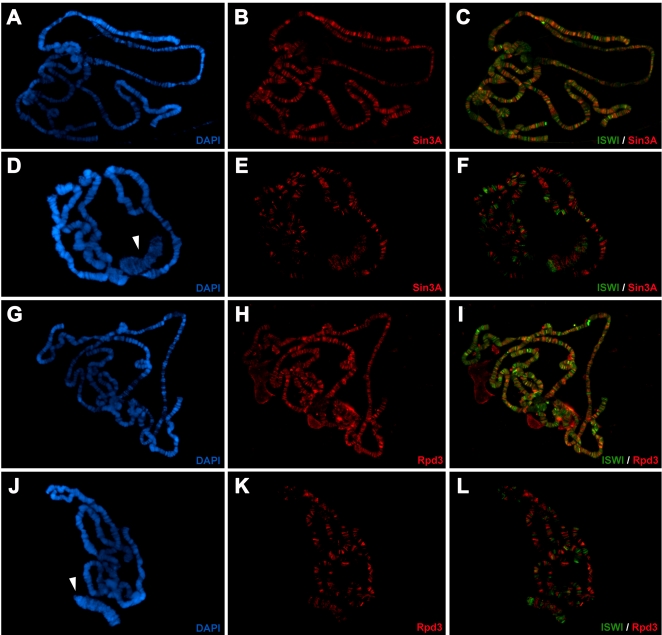
Loss of ISWI reduces the binding of Sin3A and Rpd3 to chromatin.(A and G) DAPI and immunostaining of (B) Sin3A or (H) Rpd3 on wild-type salivary gland male polytene chromosomes. (D and J) DAPI staining and distribution of (E) Sin3A or (K) Rpd3 on ISWI mutant salivary gland male polytene chromosomes. Merge of a double immunostainig for ISWI and Sin3A (C and F) or ISWI and Rpd3 (I and L) on wild-type and ISWI mutant salivary gland male polytene chromosomes, respectively. ISWI mutant chromosomes show a significant reduction in the levels of chromatin bound Sin3A and Rpd3 proteins when compared to wild-type chromosomes. The arrows mark the male X chromosome.